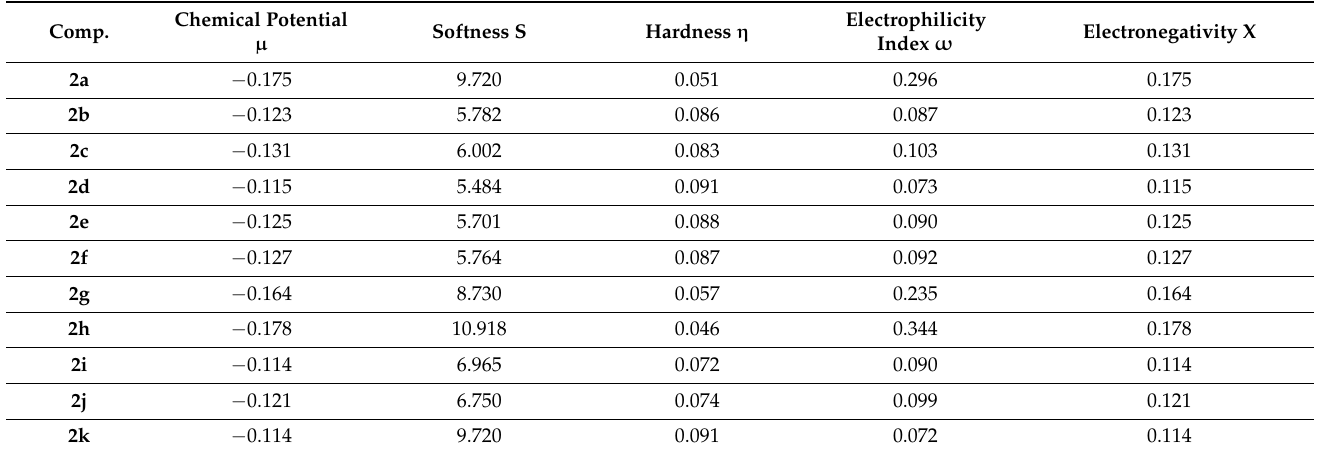
Table 3. Global reactivity descriptors.